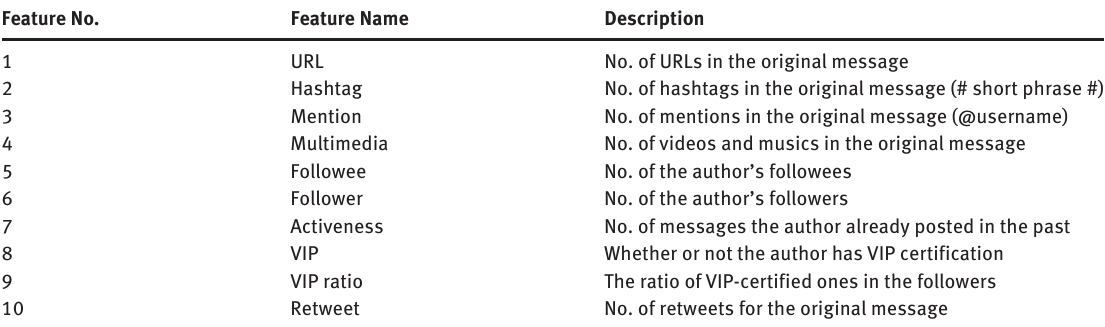
Table 2. Features.